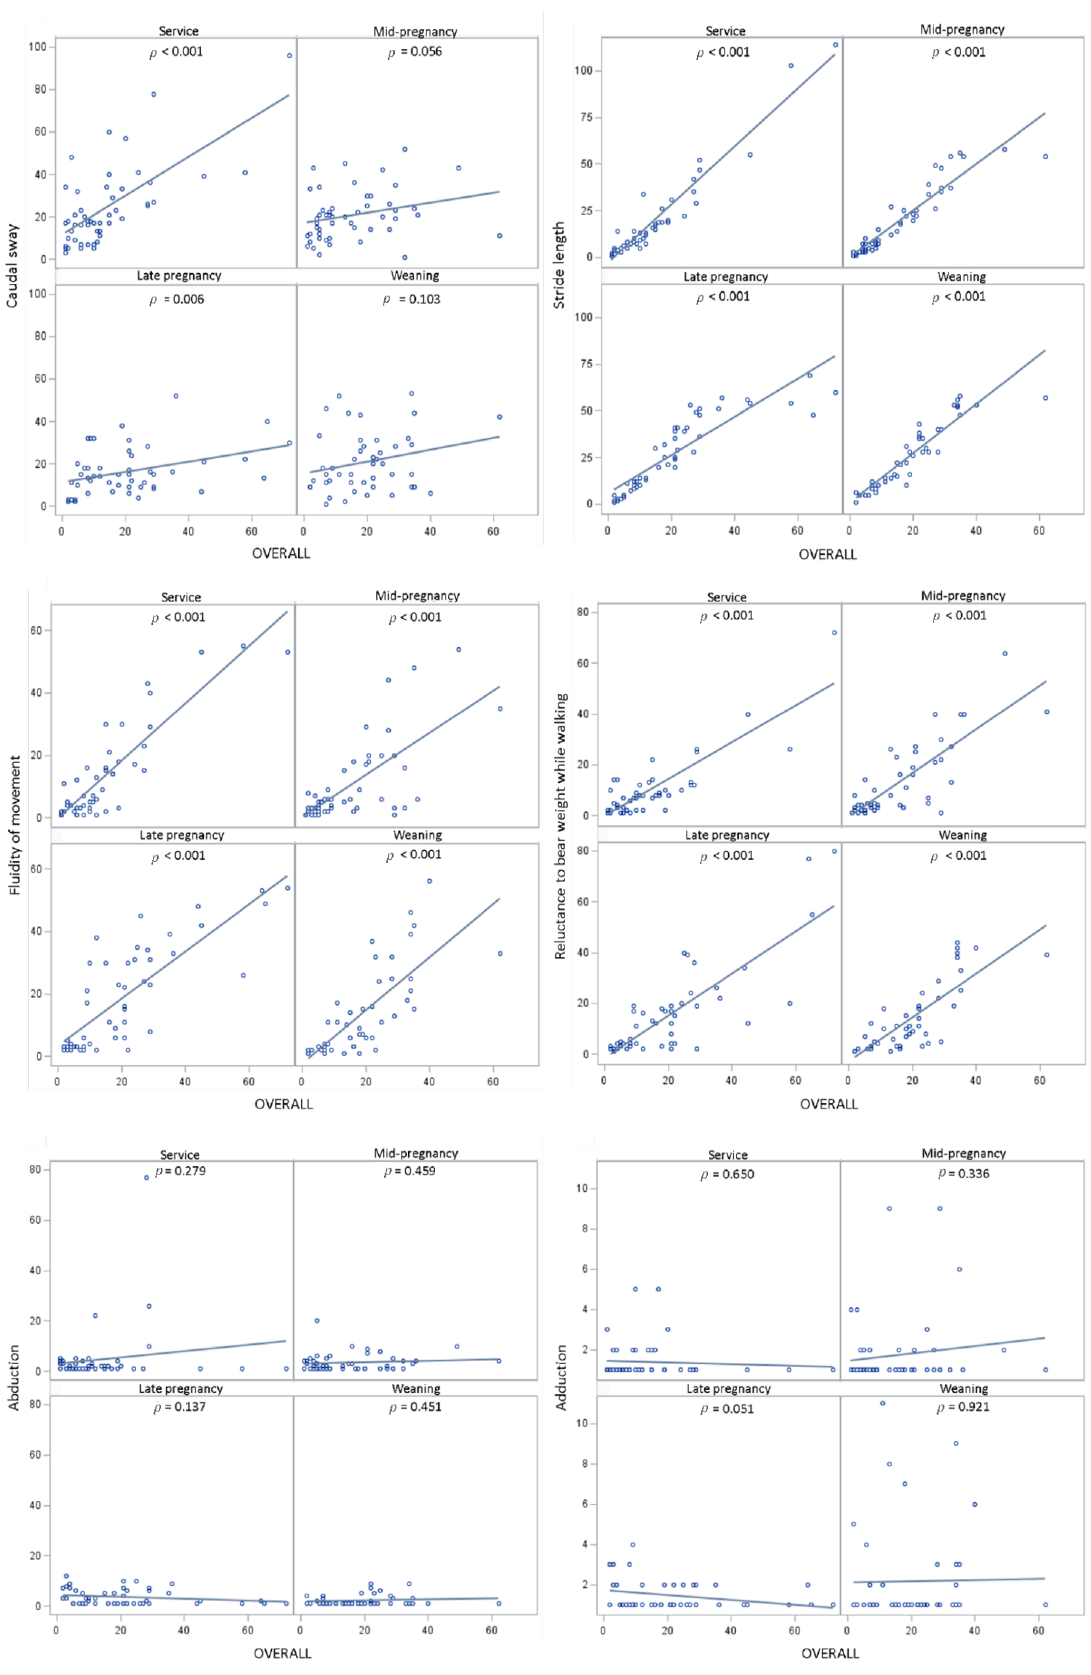
Figure A1. Individual visual analogue scale locomotion components, with descriptive sublevels based on pig locomotion assessment literature, to aid with consistency of scoring.